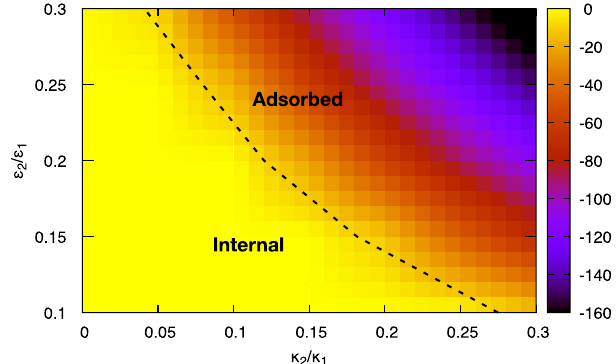
barrier and the